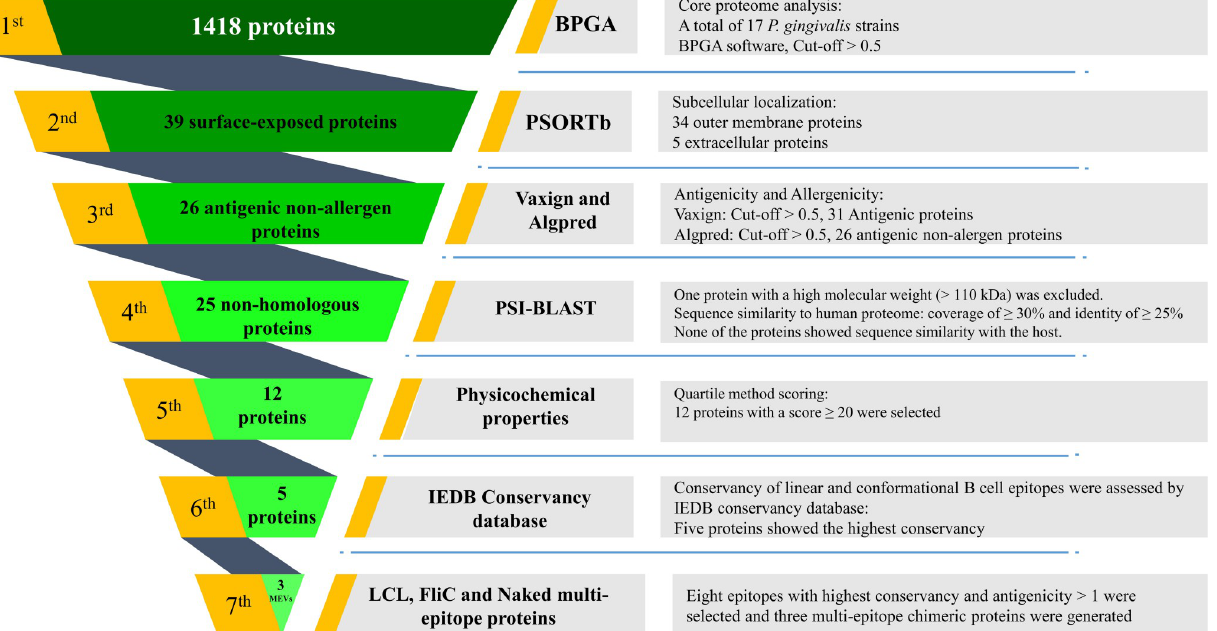
PLOS ONE | https://doi.org/10.1371/journal.pone.0273770 August 30,